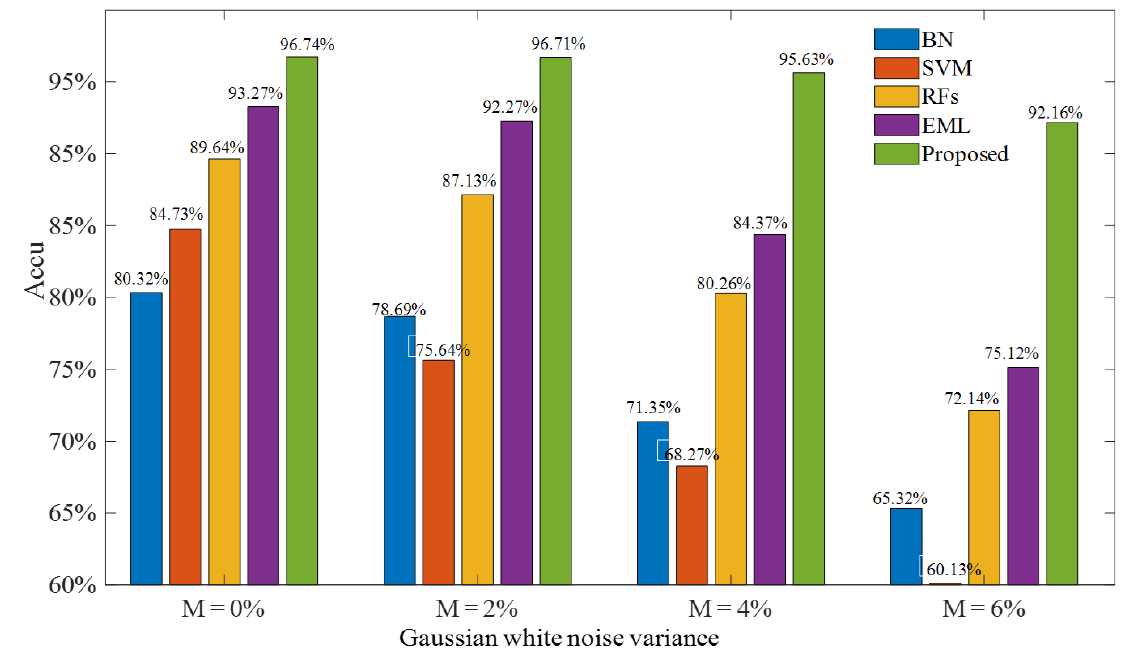
Figure 3. Robustness test result.